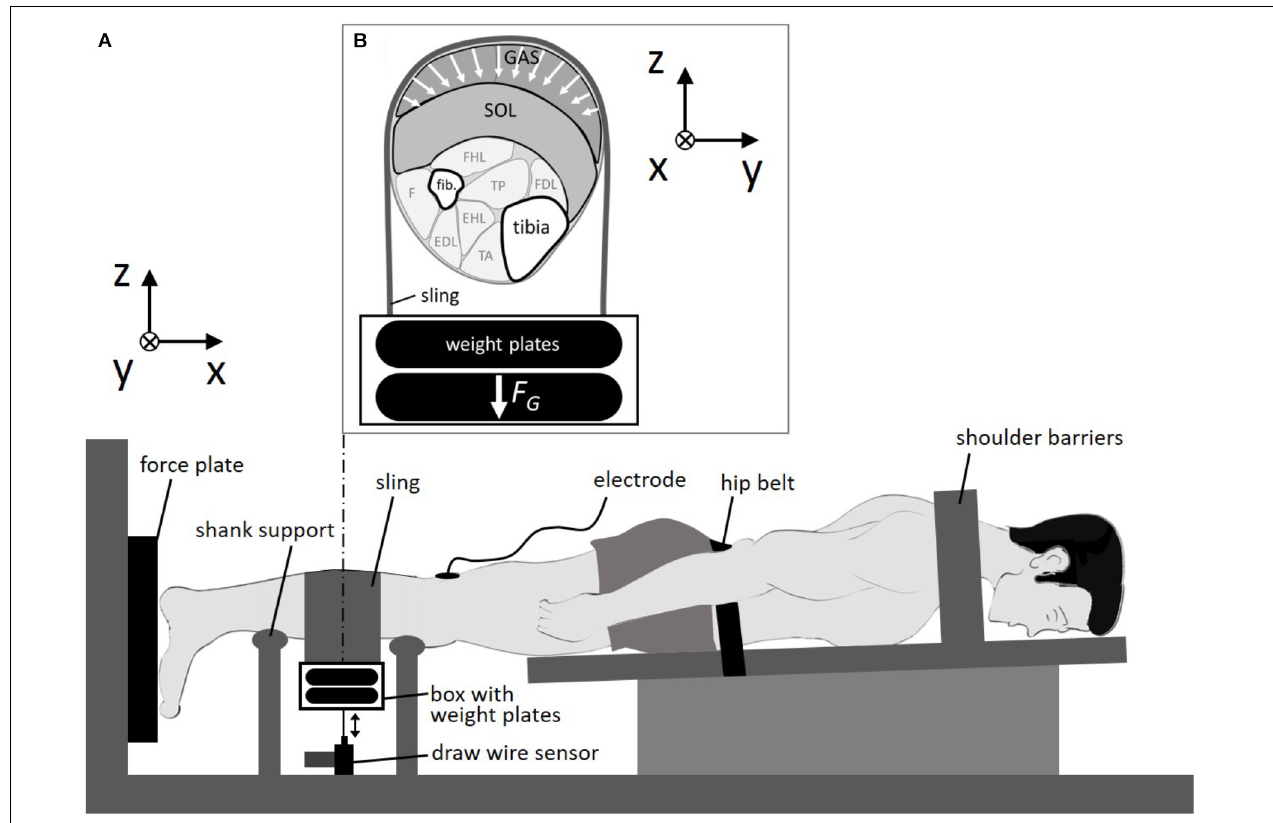
FIGURE 1 | Experimental setup. (A) Subject was fixed in a prone position. The sling was looped around the calf and loaded by weight plates. (B) Cross section of the right calf. Calf muscles were compressed by the sling in multiple directions in the transversal plane due to gravitational forces ( F G ) of the weight plates. GAS: M. gastrocnemius ; SOL, M. soleus ; fib., fibula; FHL, M. flexor hallucis longus ; FDL, M. flexor digitorum longus ; TP, M. tibialis posterior ; F, M. fibularis ; EDL, M. extensor digitorum longus ; EHL, M. extensor hallucis longus ; TA, M. tibialis anterior ; x, line of action/longitudinal direction; y-z plane, transversal